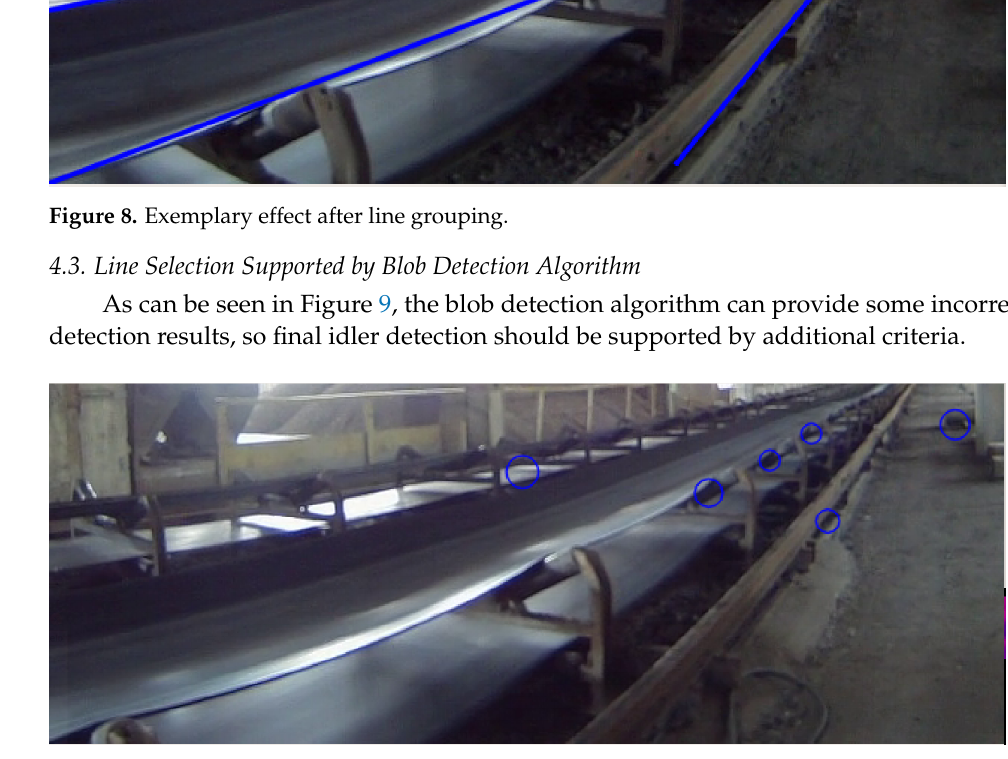
Figure 9. Example of incorrect idler blob